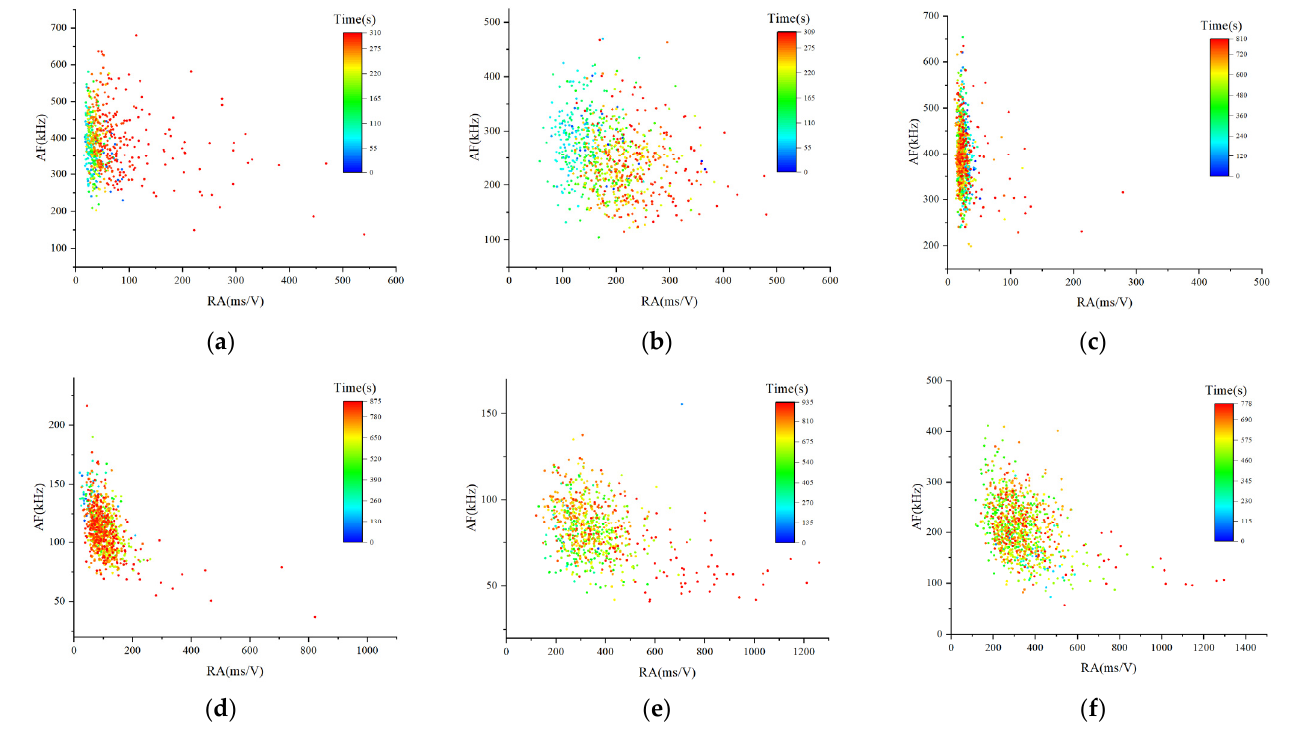
Figure 10. RA-AF correlogram: ( a ) URC-0, ( b ) URC-5, ( c ) CRC-5, ( d ) JRC-0, ( e ) JRC-5, ( f )